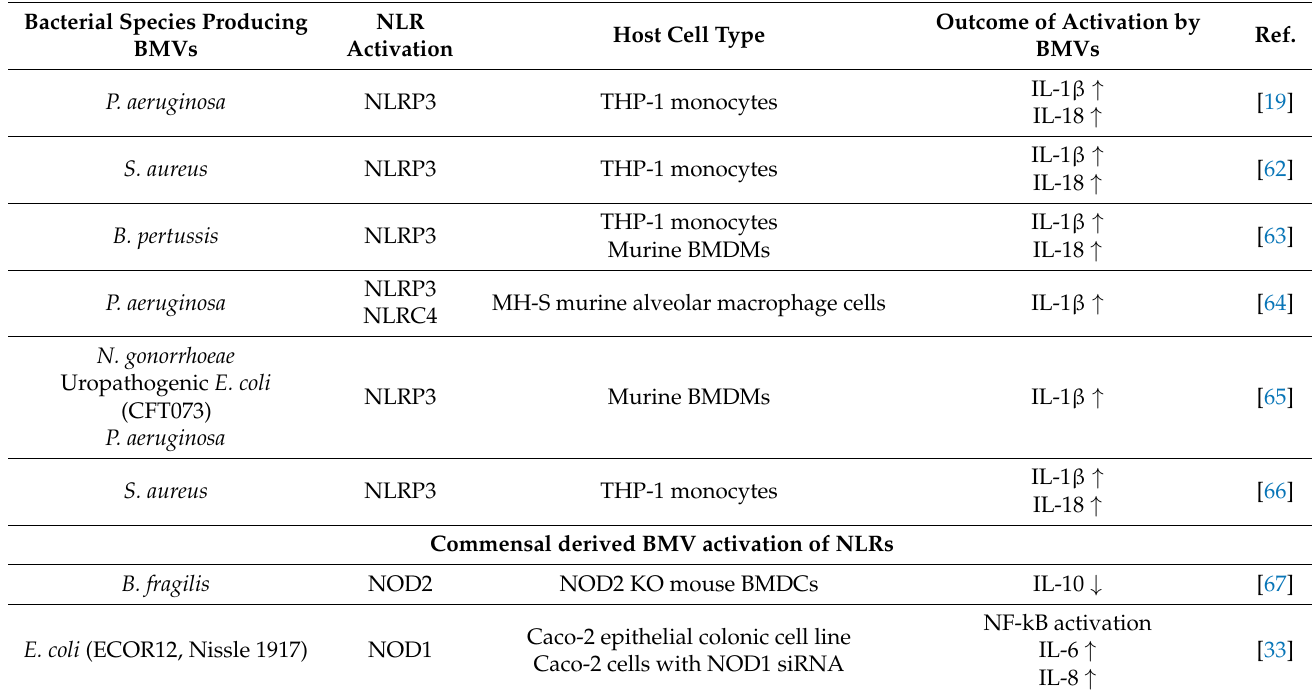
Table 1. Cont . Pathogen Derived BMV Activation of